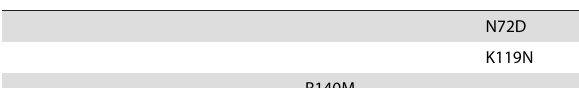
Table 4. Summary and Comparison of Amino Acid Mutations found in the HA protein of CVI and FLI Isolates.